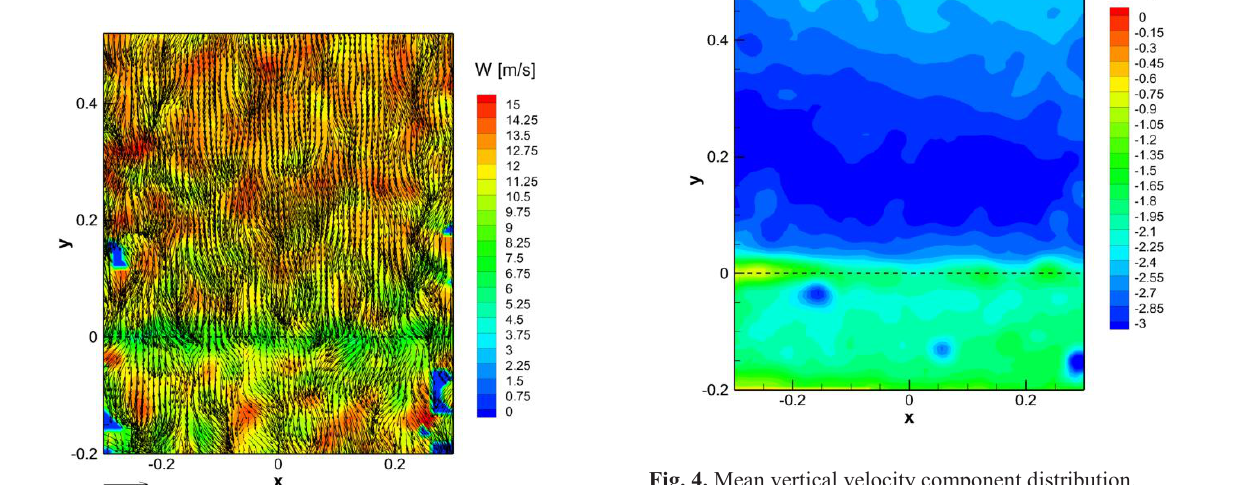
Fig. 4. Mean vertical velocity component distribution. Re =